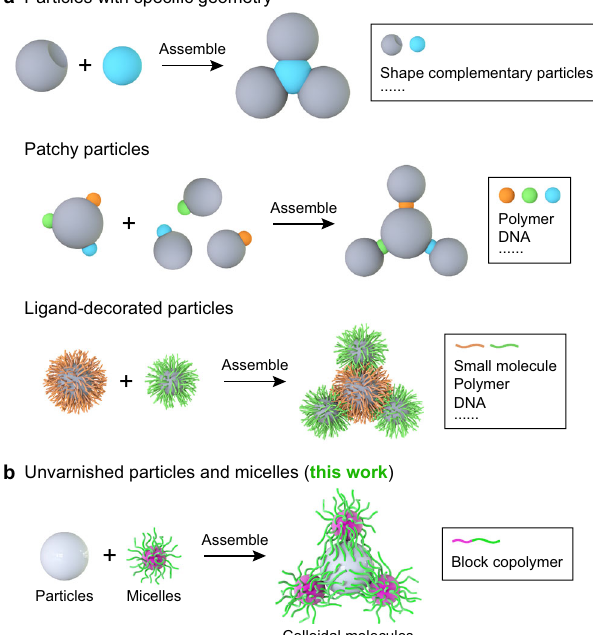
Fig. 1 General synthetic strategies for colloidal molecules. a Previously reported synthetic strategies for colloidal molecules. b Soft-hard co- assembly strategy developed in this work by directly employing unvarnished hard NPs and block copolymer